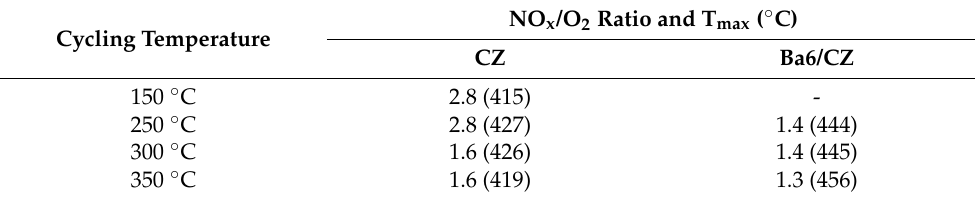
Table 3. NO x /O 2 ratios estimated from the TPD step under He, for CZ and Ba6/CZ, after NO x storage and reduction at the temperatures selected, and the corresponding temperature (T max ) of the maximum NO + O 2 release, in